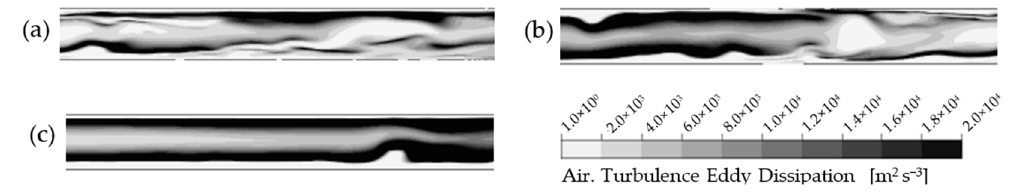
Figure 12. Contours of the air flow turbulence eddy dissipation rate illustrating changes from ( a ) and ( b ): wavy annular flow to ( c ) fully developed annular flow.